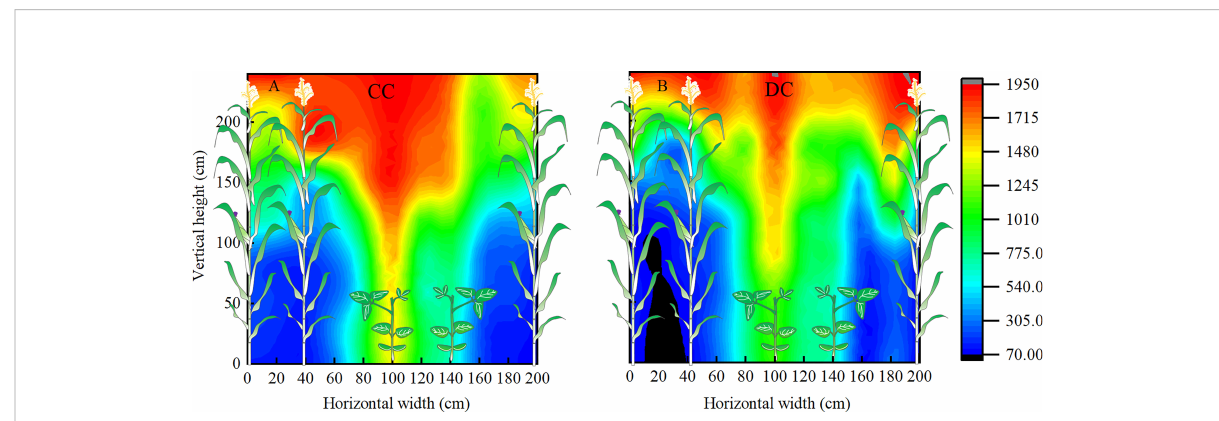
FIGURE 5 Light distribution in maize canopy. (A, B) : the light distribution of maize canopy in CC and DC at the R1 stage, respectively. DC, Dense cultivation. CC, Common cultivation. Plot values are photosynthetically active radiation (PAR, m mol m -2 s -1